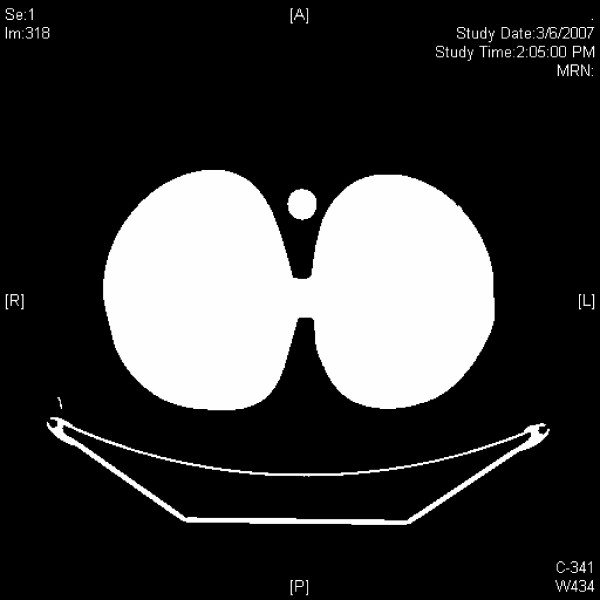
CT image of Humanoid phantom showing the location of the ion chamber at the level of the pelvis. Ion chamber was located to approximate male gonad geometry (window level set at maximum to enhance the view of the chamber).